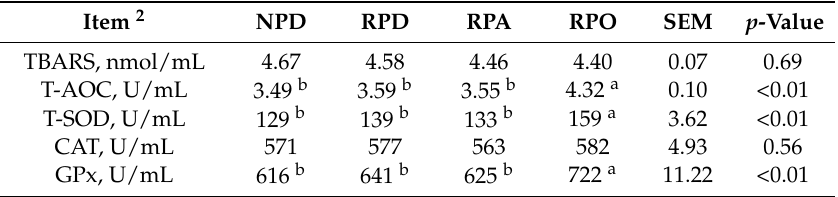
Table 6. Influences of inclusion of oregano essential oil in a low-protein diet on antioxidative enzyme activities in plasma of pigs 1